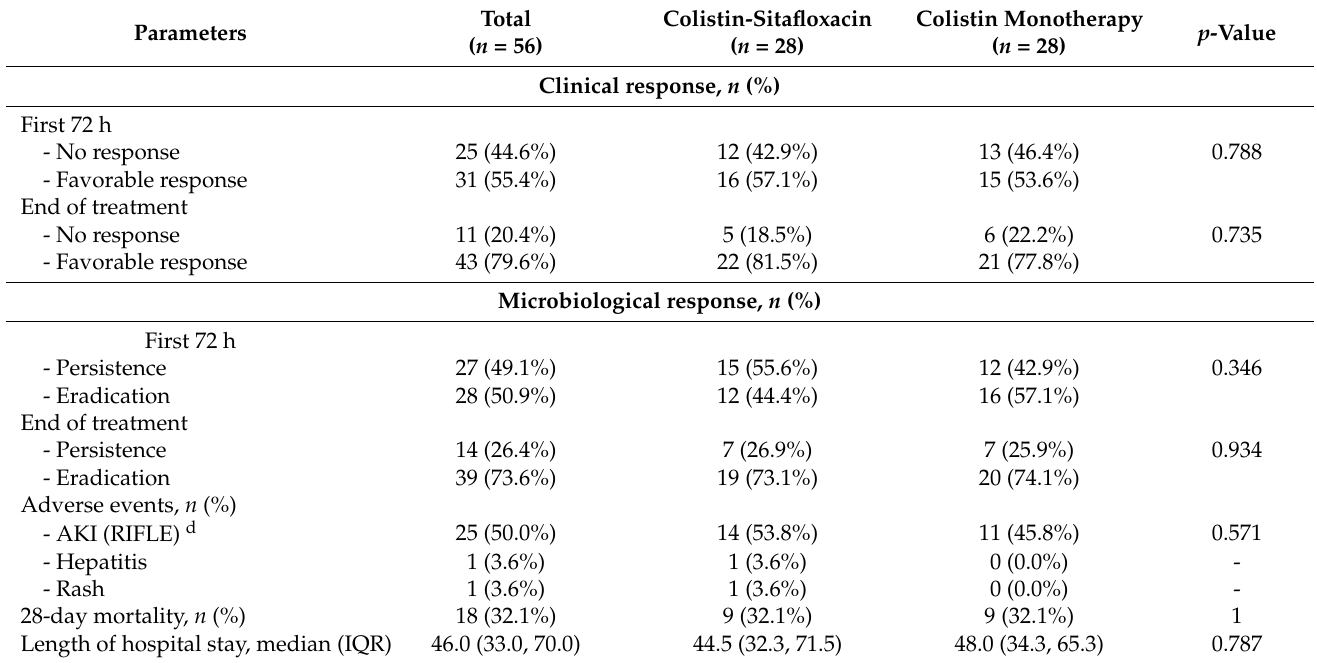
Table 3. Clinical outcomes, microbiological response, and adverse events among total patients, and compared between the combination and monotherapy groups.